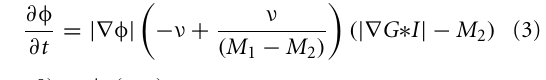
typically defined over the entire 2D image domain. Different narrow-band representations are shown in (F) Whitaker, (G) Shi, and (H) Malcolm. The Whitaker method uses 5 layers, Shi uses 2, and Malcolm uses 1